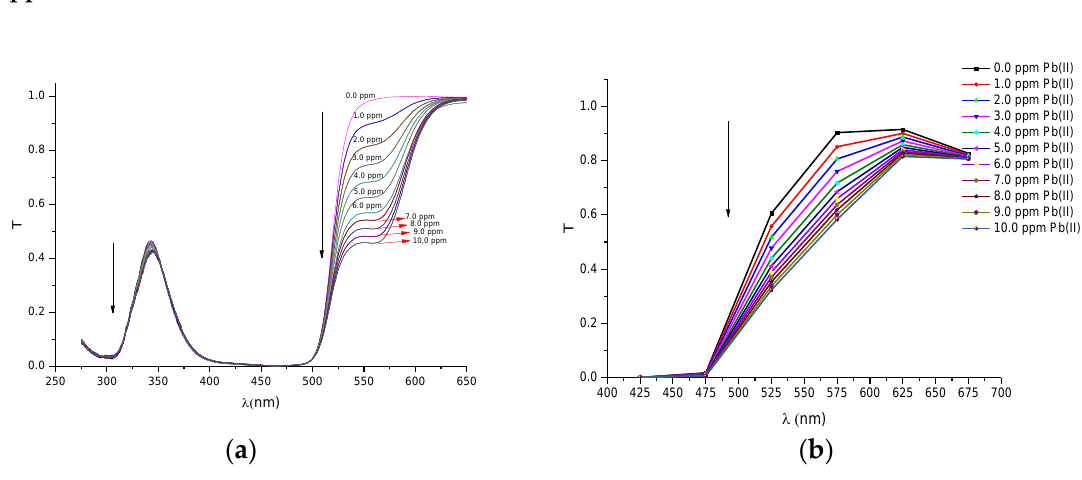
Figure A1. The transmittance spectra of the chromogen reagent of 1-(2-pyridylazo)-2-naphthol (PAN) solution containing Pb(II) ions at different concentrations corresponding to: ( a ) The UV-VIS Cary ® 50-Varian spectrometer ( b ) the multiespectral MMCS6CS sensor.